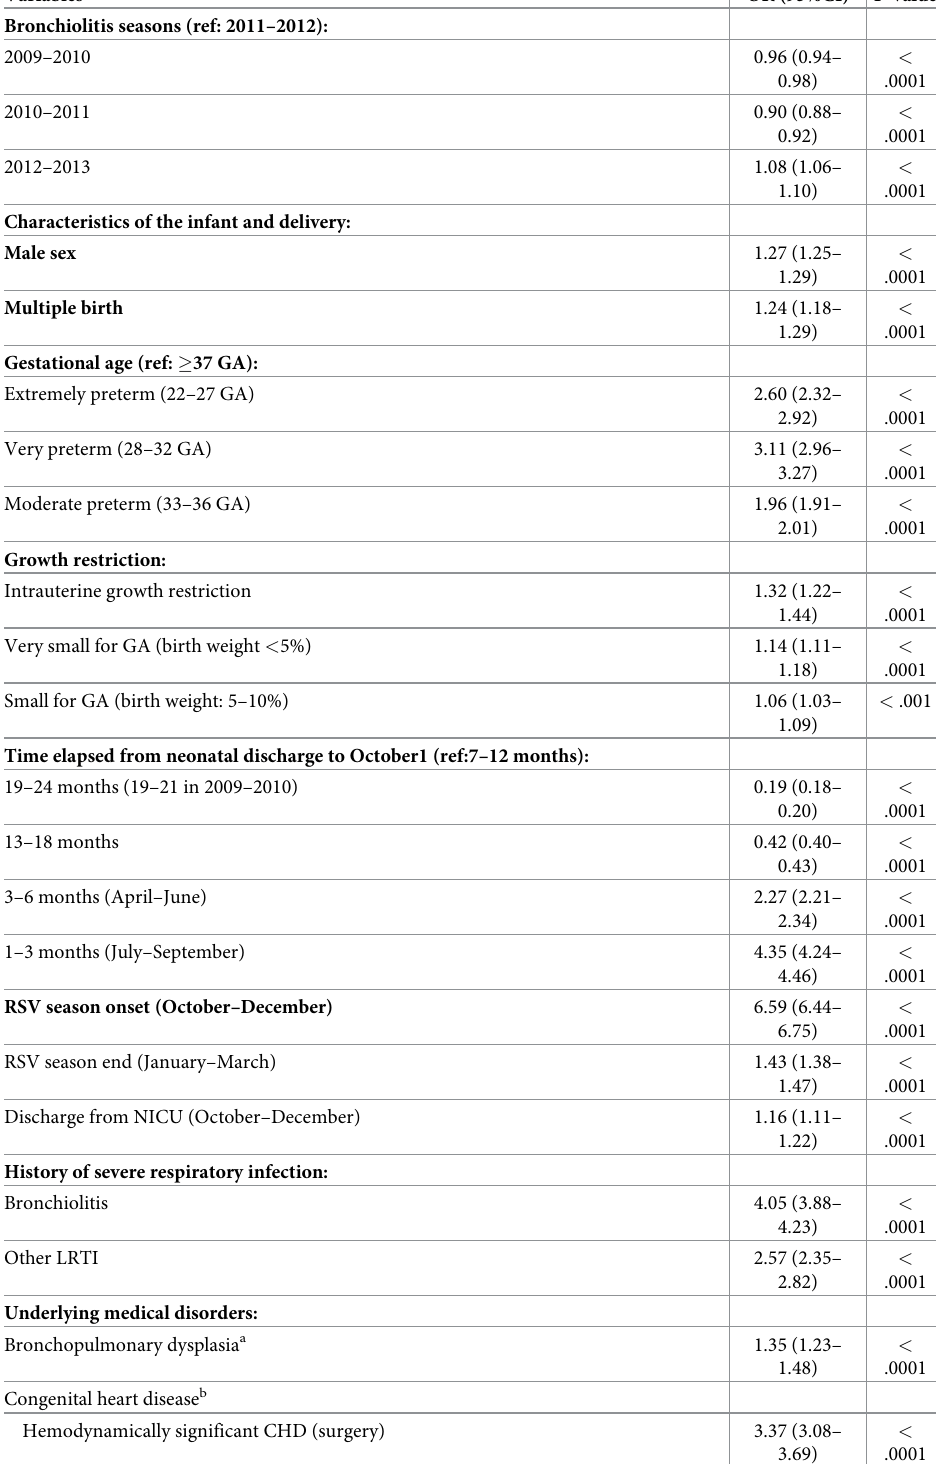
Table 3. Risk factors of hospital admission for bronchiolitis–multivariate analyses of 99,494 hospital admissions for bronchiolitis (N = 7,211,571).